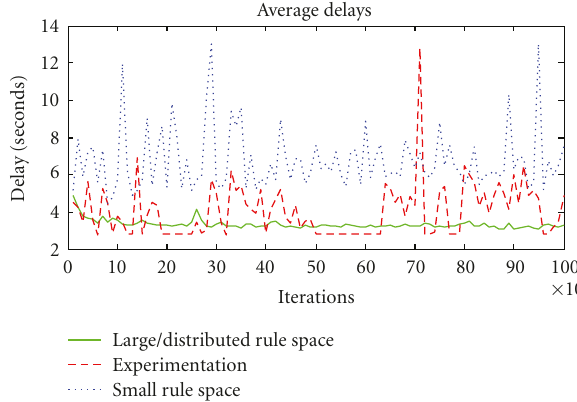
Figure 10: Comparison of delays for the 3 approaches. Each point is an average delay over 100